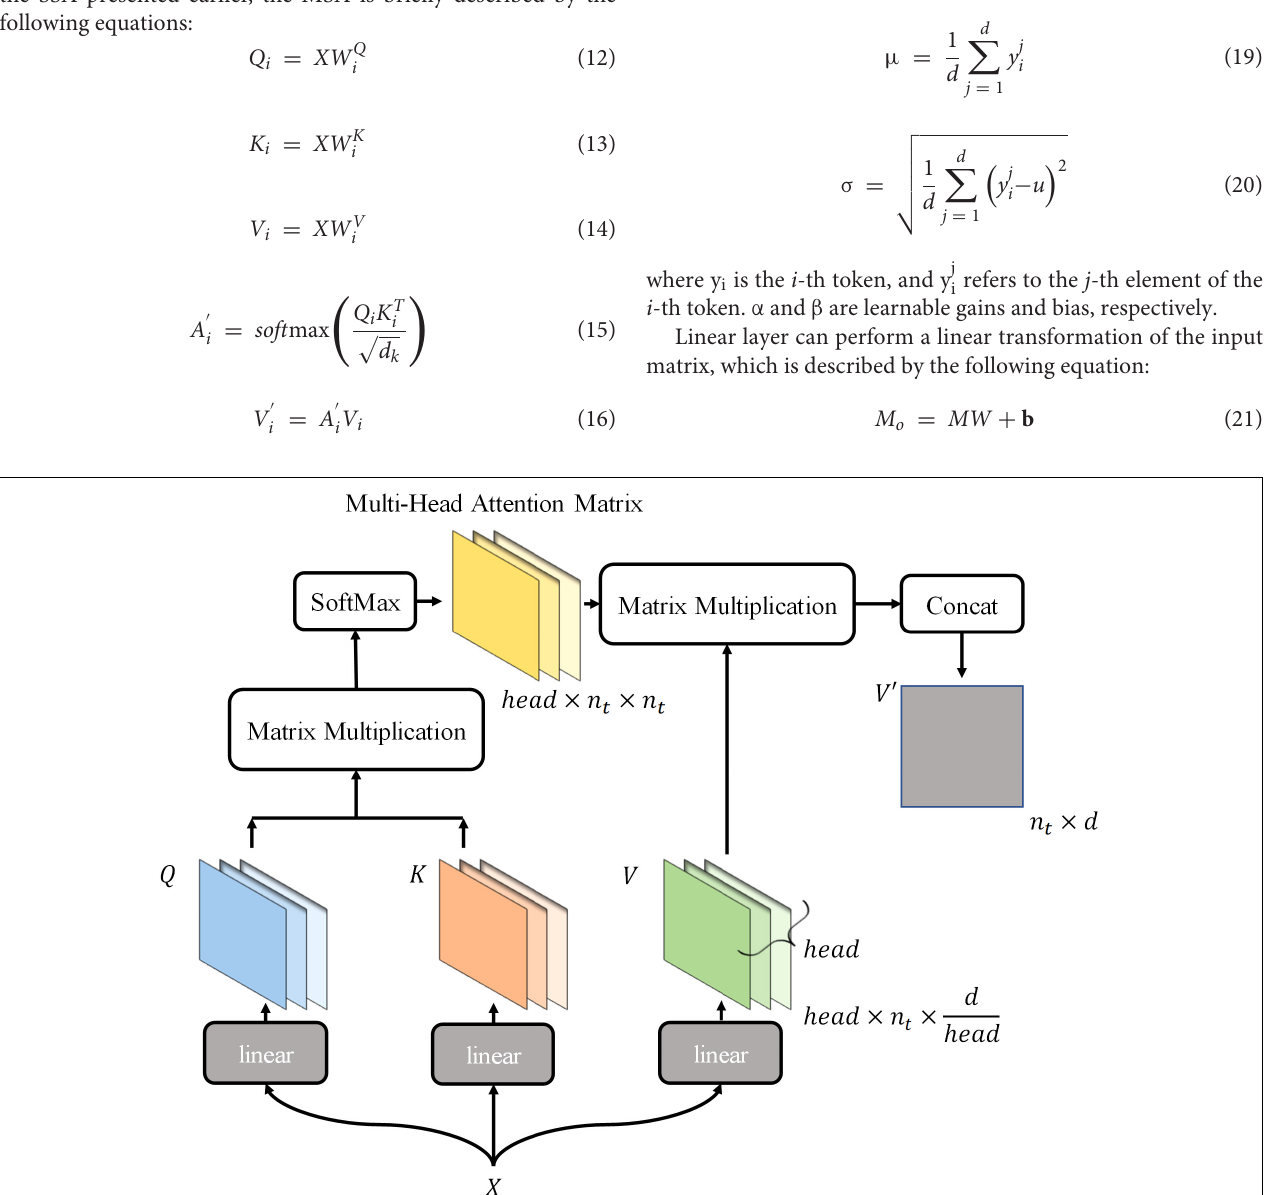
FIGURE 4 | The schematic of implementing multi-head